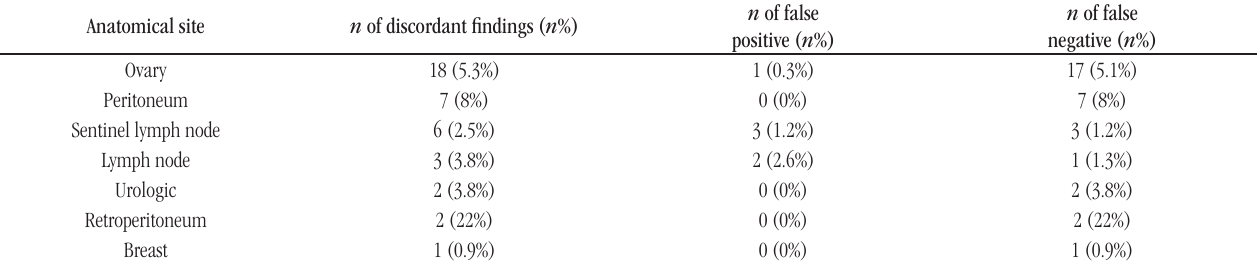
taBLE 2 − Distribution of discordant findings after reassessment in relation of evaluated organs ( n = 39) Anatomical site